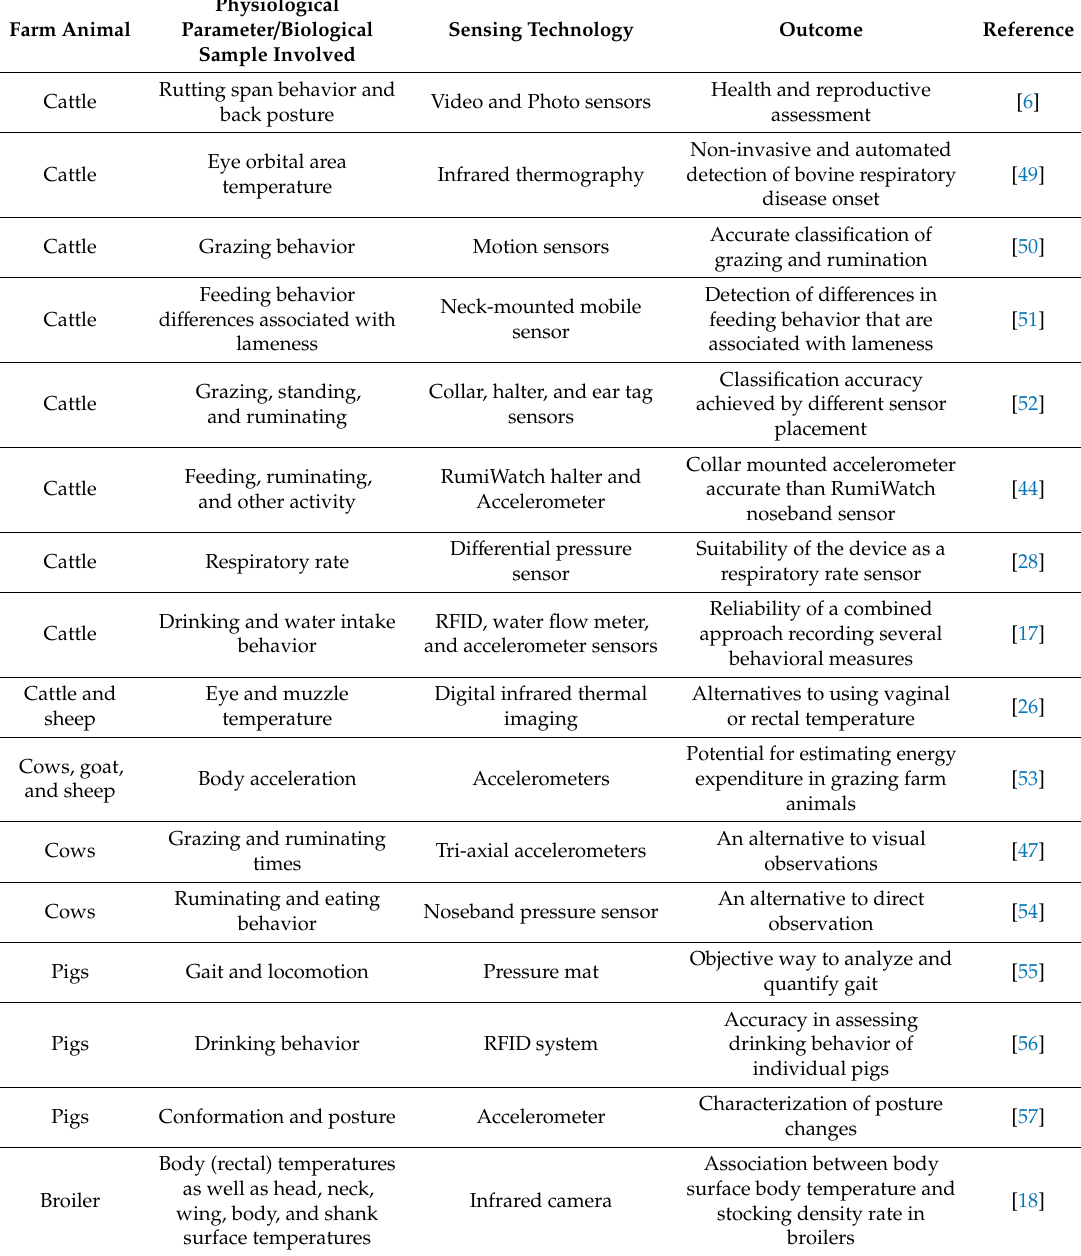
Table 1. Outcomes of using sensor technology for assessing adaptation physiology of farm